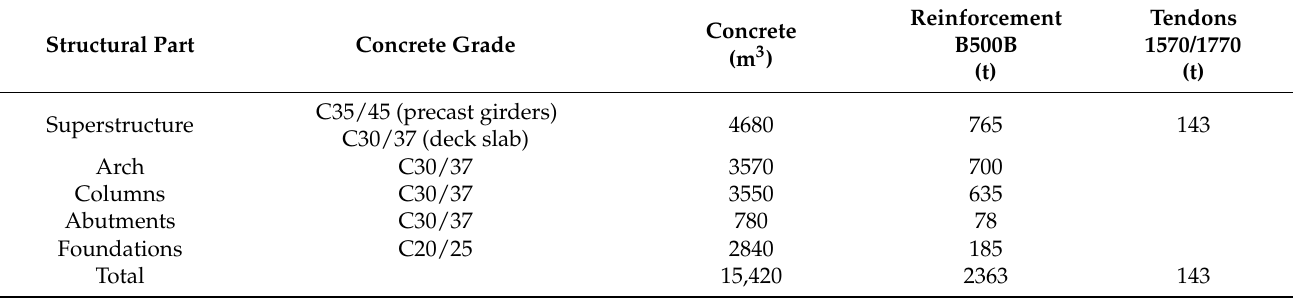
Table 1. Structural material quantities.